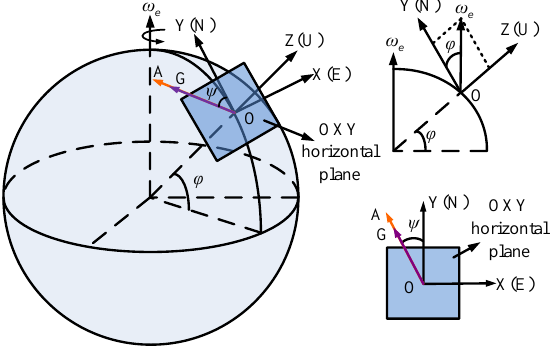
Figure 3. The east, north, up geographical coordinate